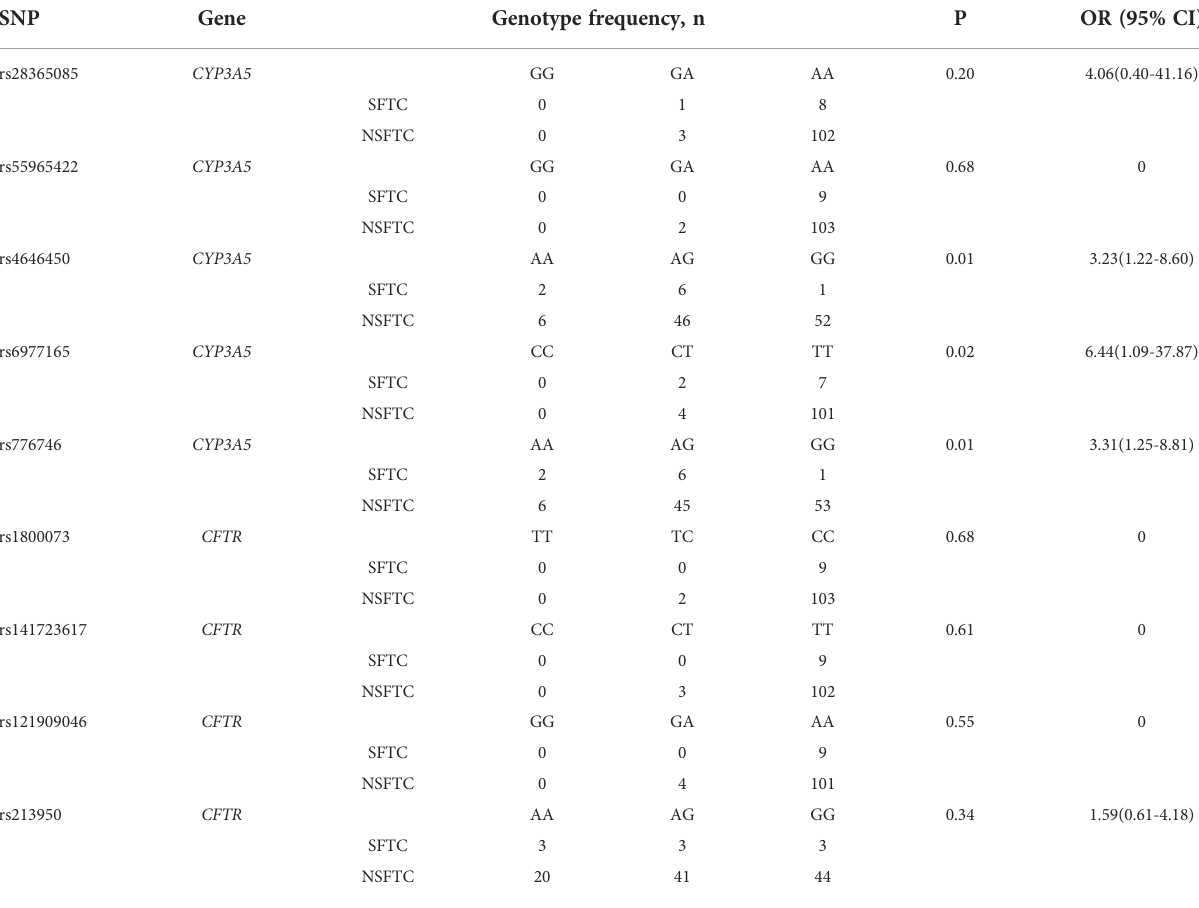
TABLE 3 Comparison of genotype distribution between SFTC and NSFTC